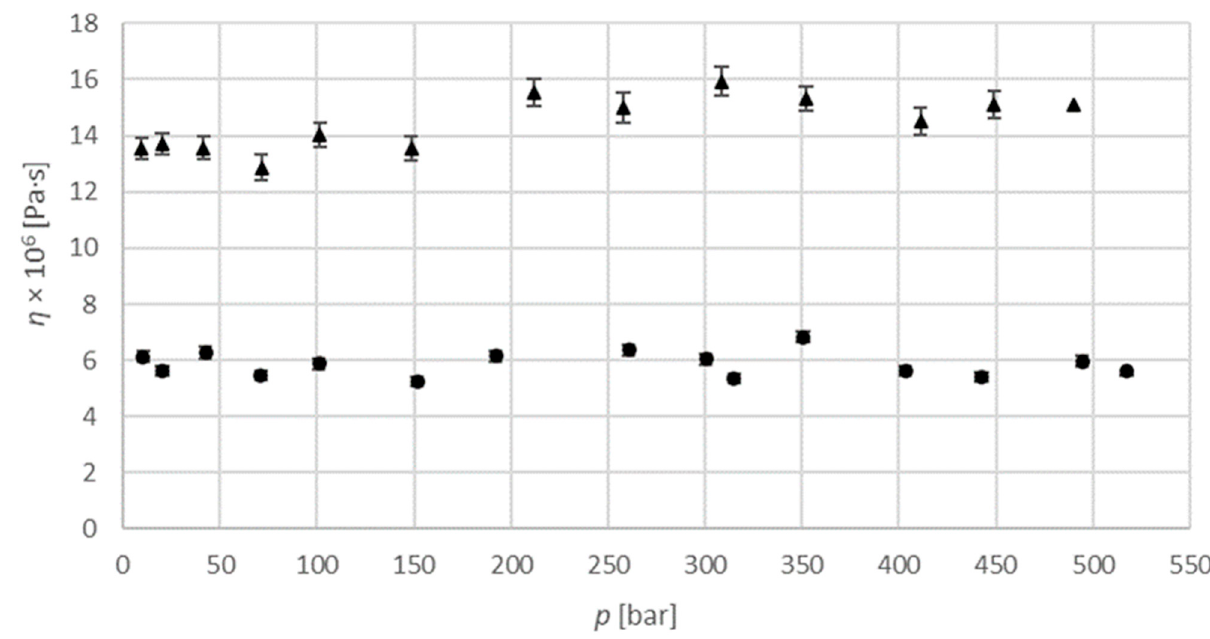
Figure 6. Viscosity of the argon-saturated isopropanol binary system: Figure 4. The viscosity of pure gas as a function of pressure in comparison to literature data: , , measured data at 313.15 K; Figure 5. Viscosity of the CO Figure 6 . Viscosity of the argon-saturated isopropanol binary system: , measured data at 313.15 2 -saturated isopropanol binary system: , measured data at 313.15 K; measured data at 313.15 K; , measured data at 333.15 K; X, pure gas at 313.15 K [16]; , pure gas , measured data at 333.15 K; , measured data at 333.15 K. at 333.15 K [16].